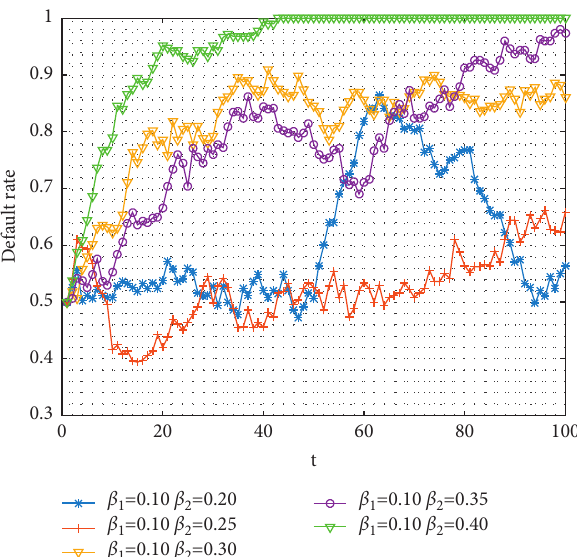
Figure 2: Diffusion of default behavior in a scale-free network with the increase of β